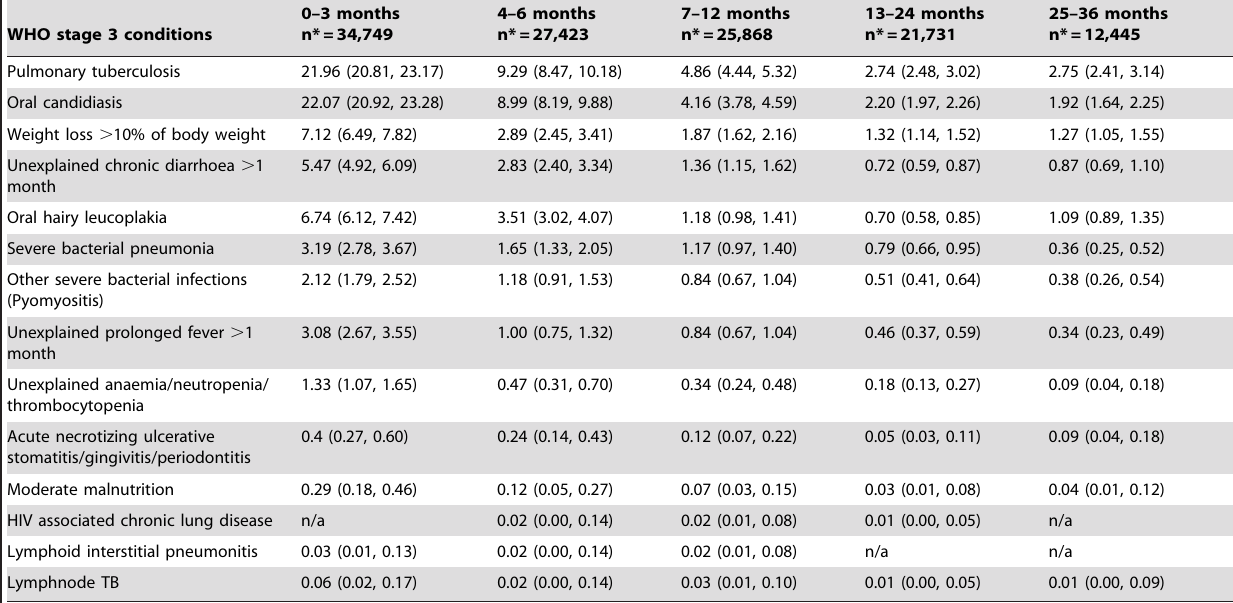
Table 2. Disease specific incidence over 36 months for selected WHO Stage 3